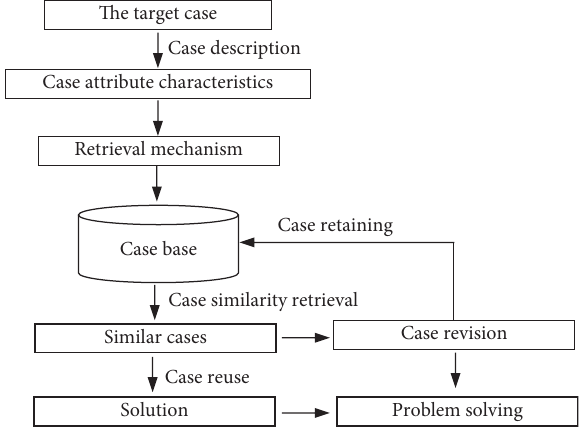
Figure 1: General principles of